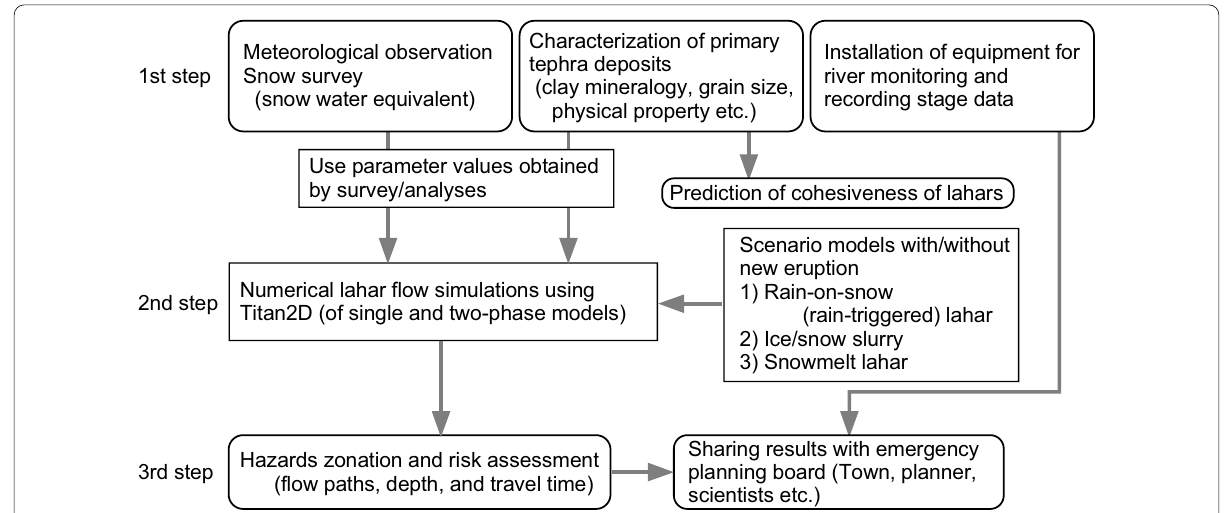
Fig. 3 Approach and methodology taken for lahar hazards and risk assessment in the 2018 Kusatsu-Shirane eruption